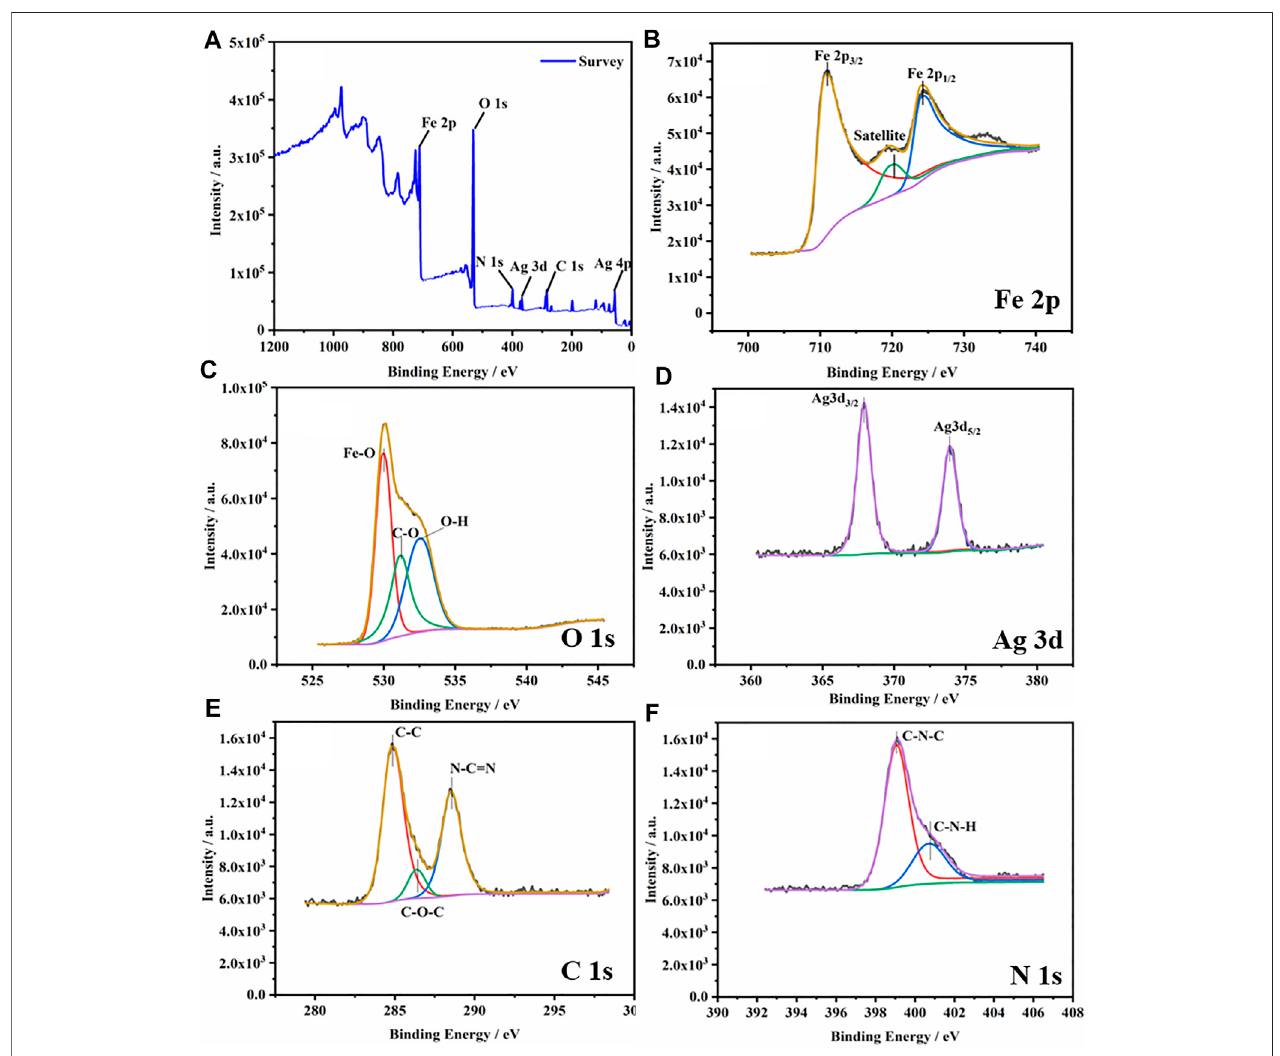
FIGURE 3 | (A) XPS Spectra of g-C 3 N 4 (5 wt%)/Ag/ γ -FeOOH. (B) High-resolution spectrum of Fe 2p in the composite, (C) O 1s, (D) Ag 3d, (E) C 1s, (F) N 1s.